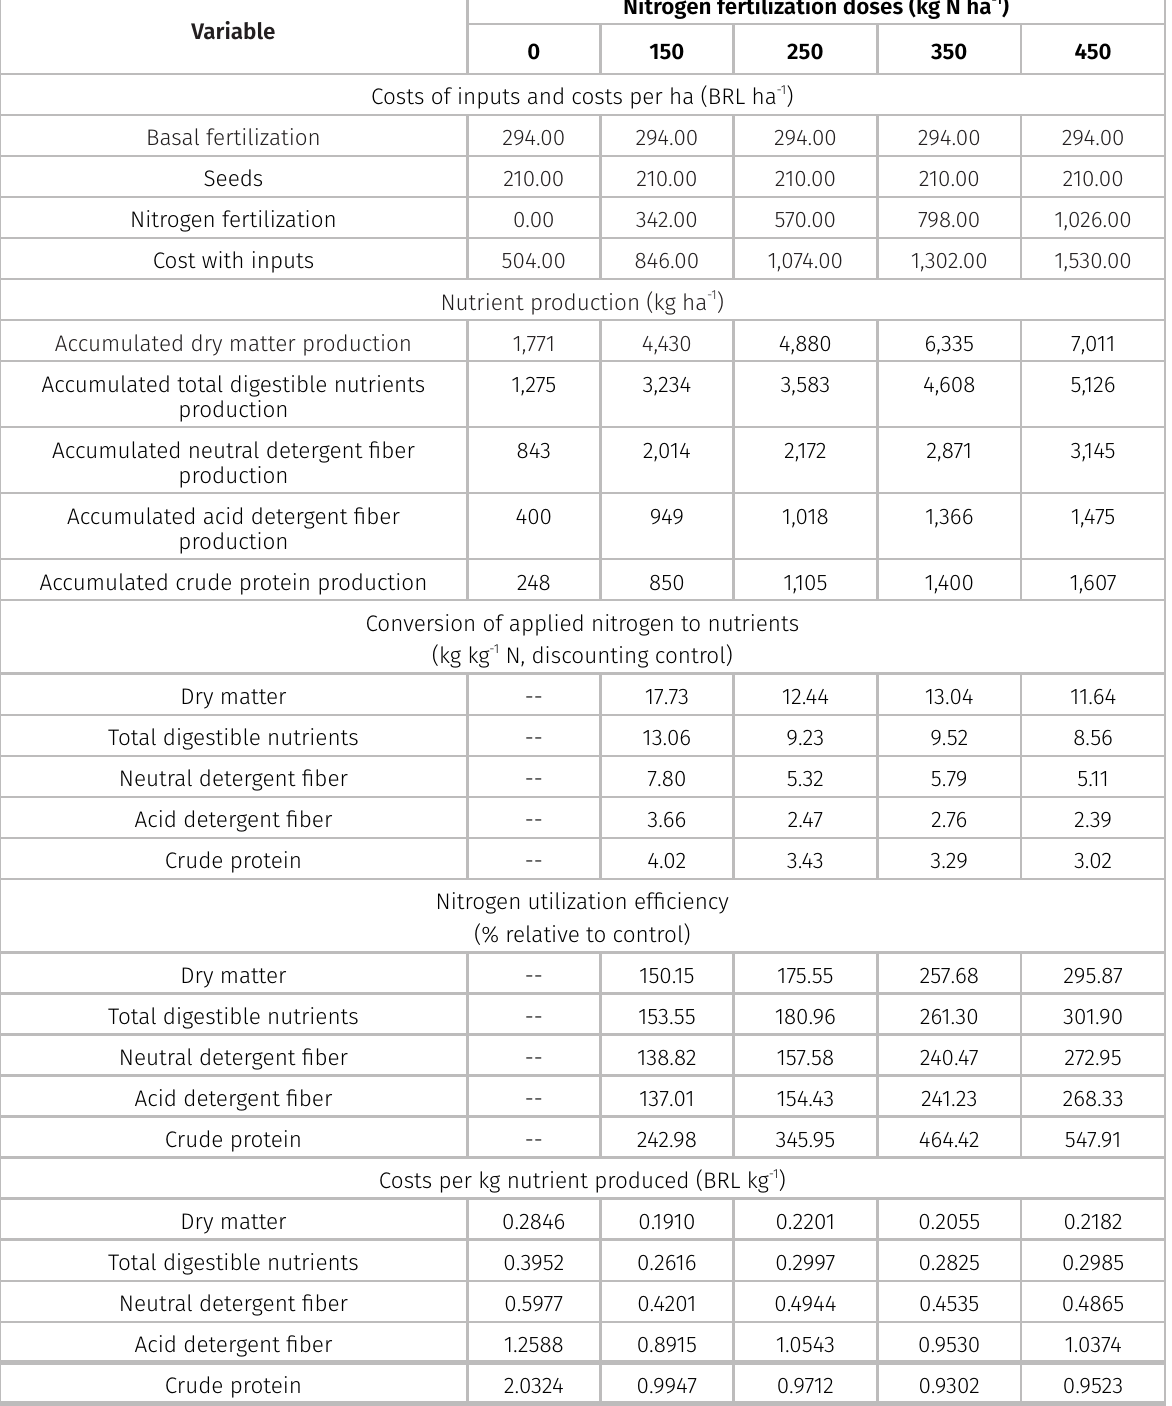
Table VI. Costs of inputs used, nutrient yields, conversion of applied nitrogen to nutrients, nitrogen utilization efficiency, and costs per kg nutrients produced in dual-purpose wheat pasture BRS Tarumã managed with different nitrogen